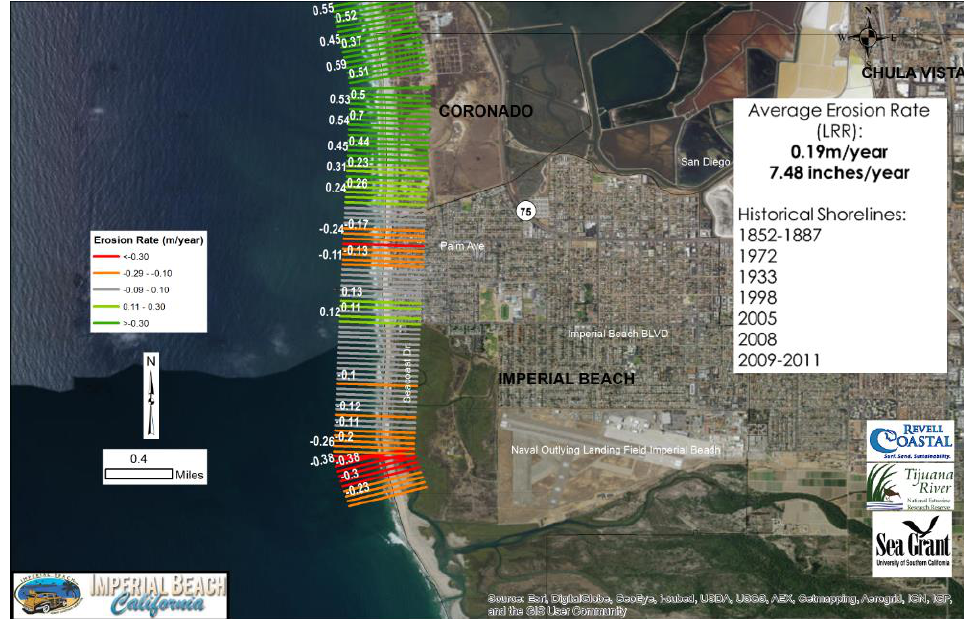
Figure 6. Shoreline change rates for 159-year historical time period. Erosion hot spots shown in red. Green is accretion. Grey is within the range of uncertainty.